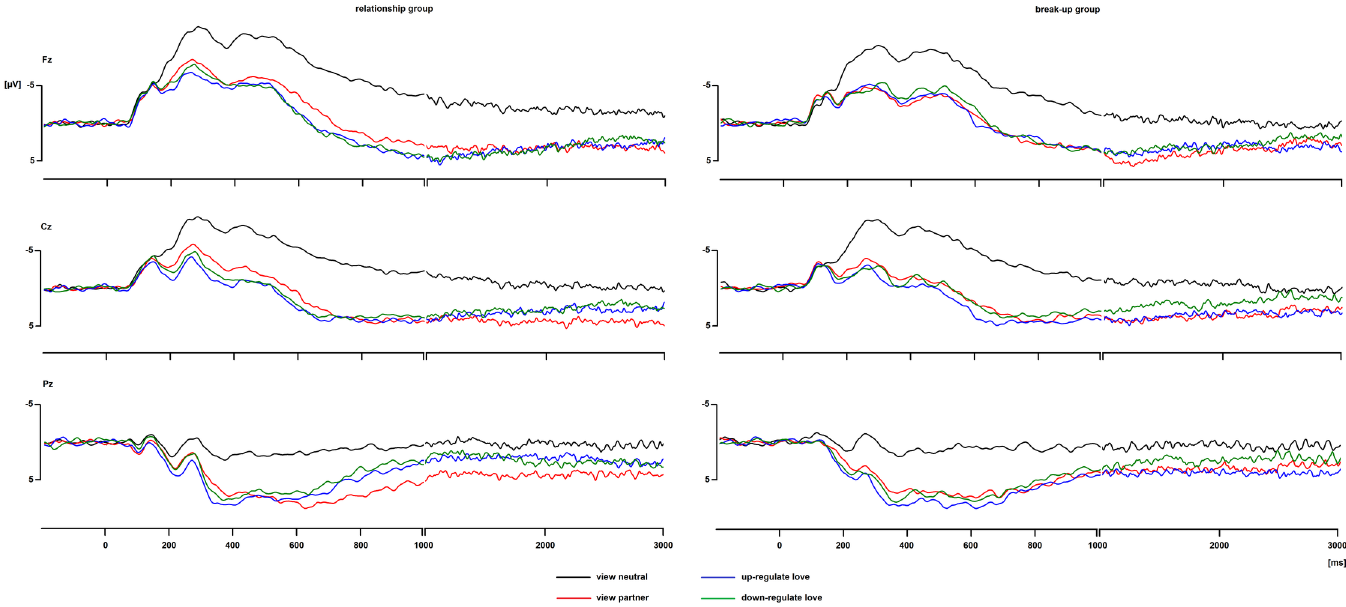
Fig 5. ERP waveforms at Fz, Cz, and Pz for the four conditions, for each group